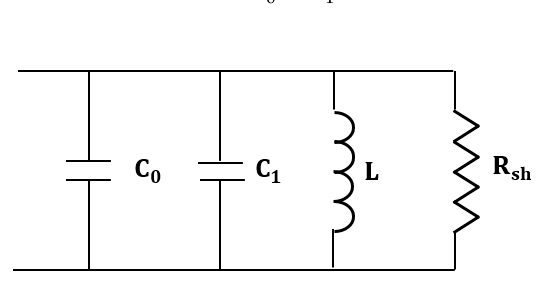
Figure 2. Equivalent lumped circuit for the re-entrant cavity.